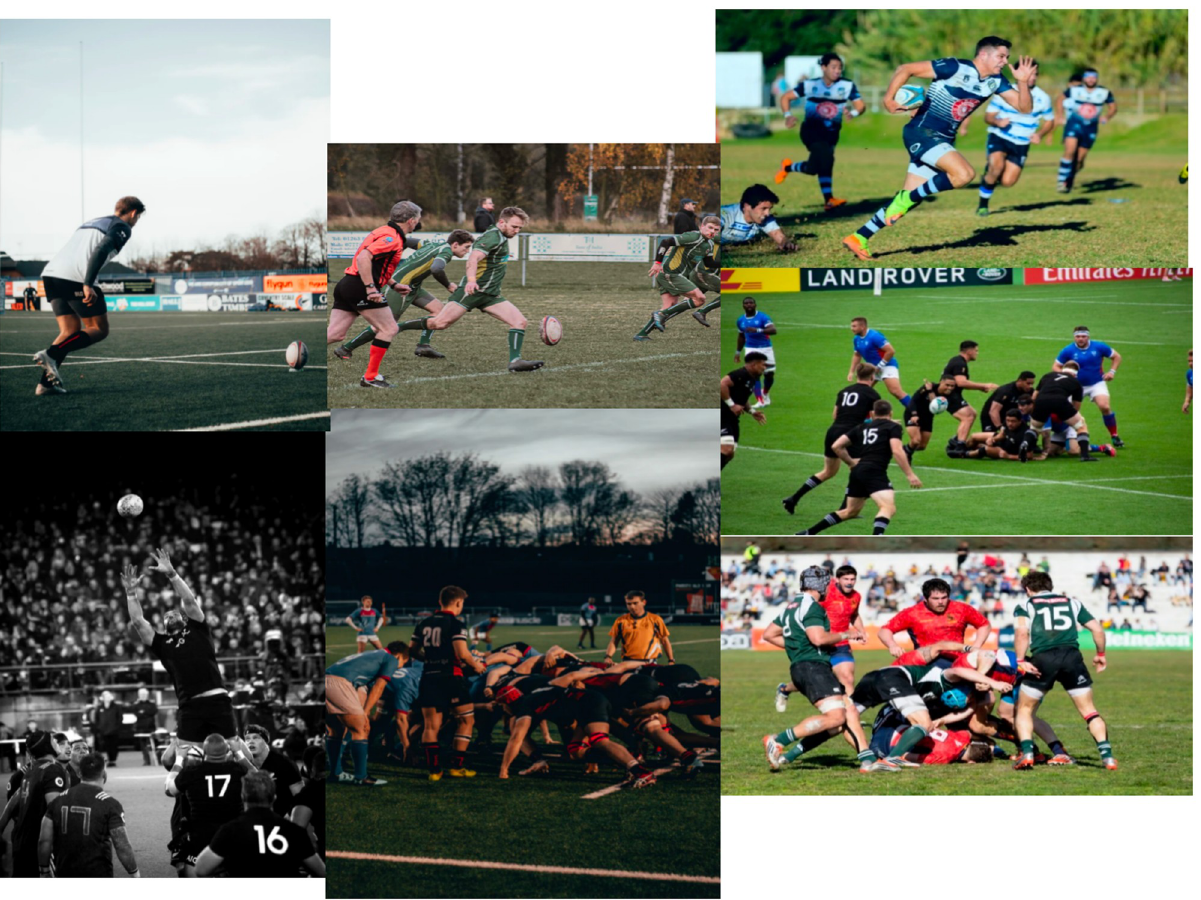
Fig 2. Key events in rugby matches. The photographs used as the original images are listed in parentheses. All of them are licensed under the unsplash. com license (https://unsplash.com/license). Top left: Kick at goal (https://unsplash.com/photos/xJSPP3H8XTQ); Bottom left: Line-out (https:// unsplash.com/photos/CTEvFbFpVC8); Center top: Kick restart/Kick-off (https://unsplash.com/photos/OMdge7F2FyA); Center bottom: Scrum (https://unsplash.com/photos/y5H3_7OobJw); Top Right: Line break (https://unsplash.com/photos/XAlKHW9ierw); Middle Right: Beginning of a phase (https://unsplash.com/photos/fqrzserMsX4); Bottom Right: Breakdown (https://unsplash.com/photos/WByu11skzSc).